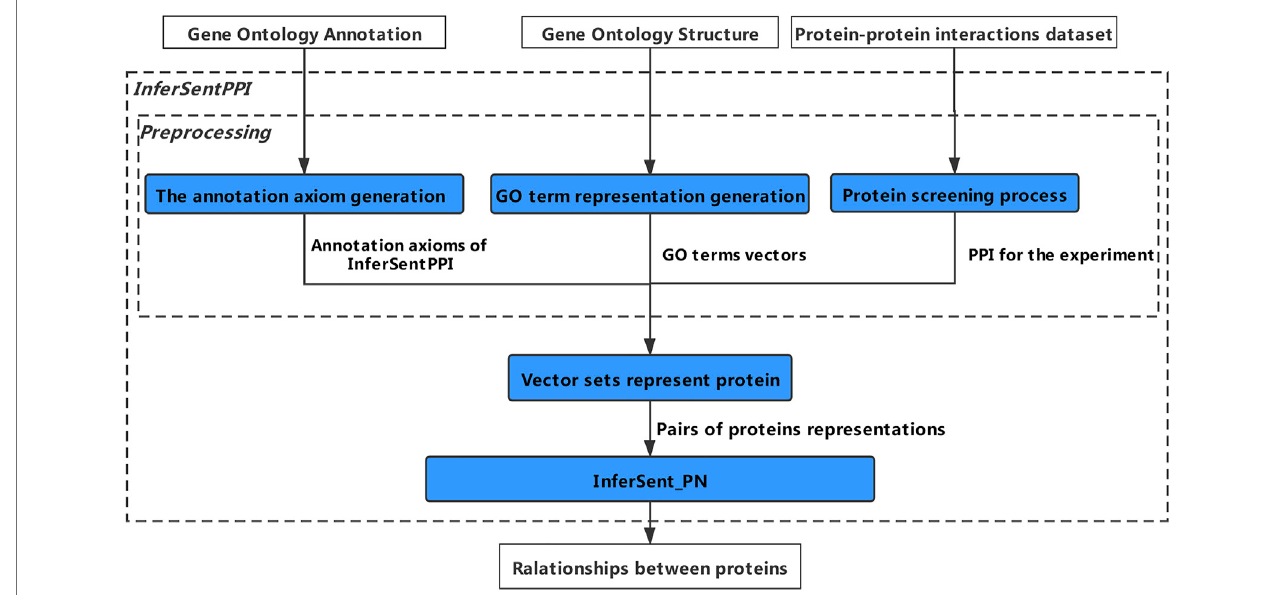
FIGURE 1 | The work fl ow of InferSentPPI method.